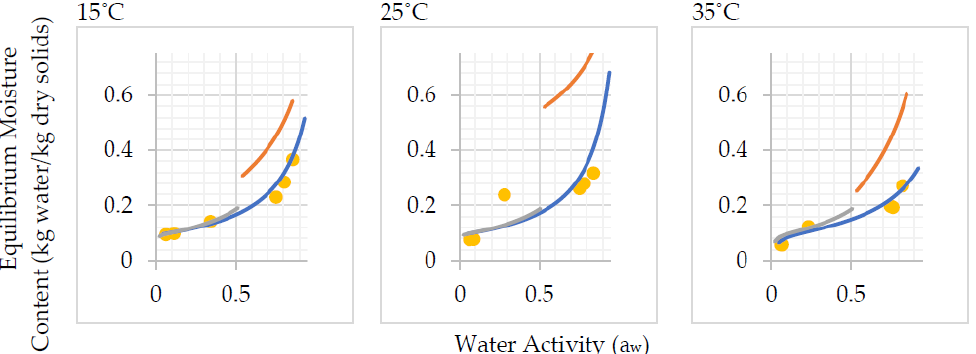
Figure 3. Comparison of predicted sorption isotherm curve for fresh feces using the BET, GAB, and Smith models with experimental equilibrium moisture contents. The dots represent the experimental average. The GAB model was fitted to the entire activity range and both the Smith and BET models were fitted to the activity range that they are used to describe (Table 2). Water 2020 , 12 , x FOR PEER REVIEW The heat of sorption was calculated from the plot of ln(a w ) vs. 1/T with the GAB model (Figure 4). The total heat of evaporation was significant up to a moisture content of about 0.2 kg water per kg dry solids (at this moisture content, the curve becomes asymptotic (Figure 4)).